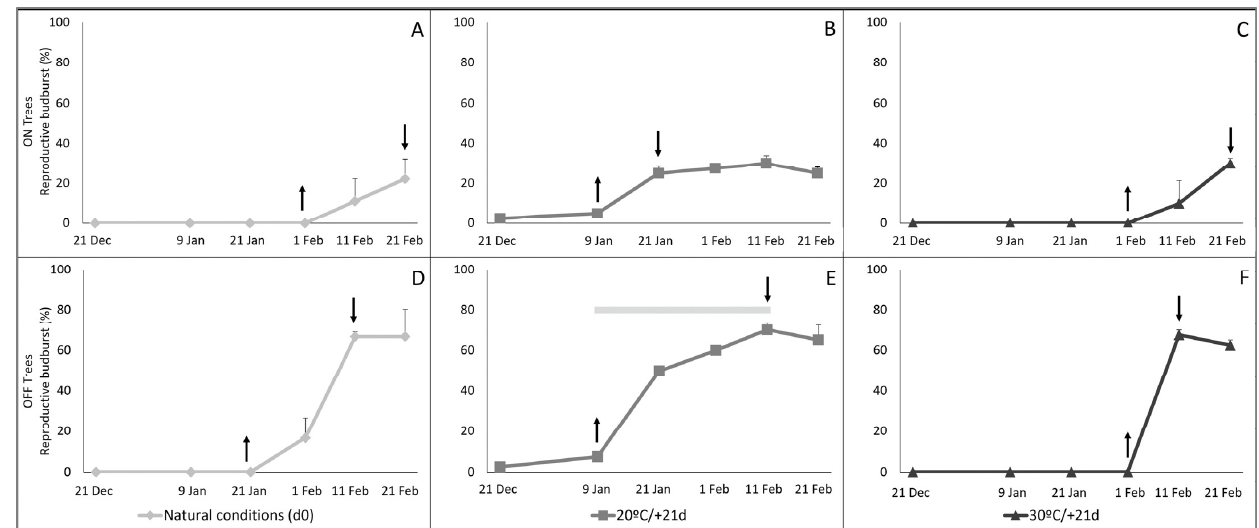
Figure 1. Reproductive budburst following natural chilling in the field of buds present on the trees and on cuttings sampled on the indicated dates and then forced under controlled conditions. Trees were bearing (ON; upper graphs ( A – C )) and non-bearing (OFF; lower graphs ( D – F )). Cuttings were forced in growth chambers at 20 °C and 30 °C, for 21 days (20 °C/+21 d and +30 °C/+21 d). Natural budburst in the field was observed on the sampling date (d0). For OFF, each point represents the average of 240 buds (10 cuttings with 6 buds per 4 trees) in the growth chambers and of 80 buds (20 buds per 4 trees) in the field at d0. For ON, there were 3 trees, so each point represents the average of 180 buds in the growth chambers, 60 buds in the field. Arrows delimit the onset and completion of the budburst period; broad horizontal line in ( E ) shows reference budburst period at 20 °C forcing [8]. Vertical bars = standard error.